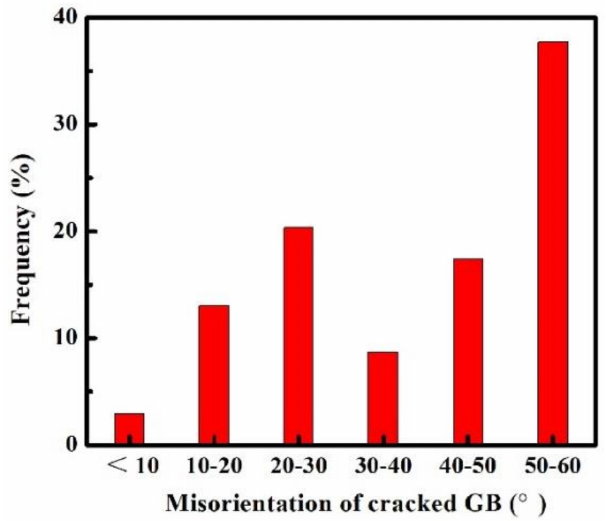
Figure 6. Population of GB types of original IF steel.